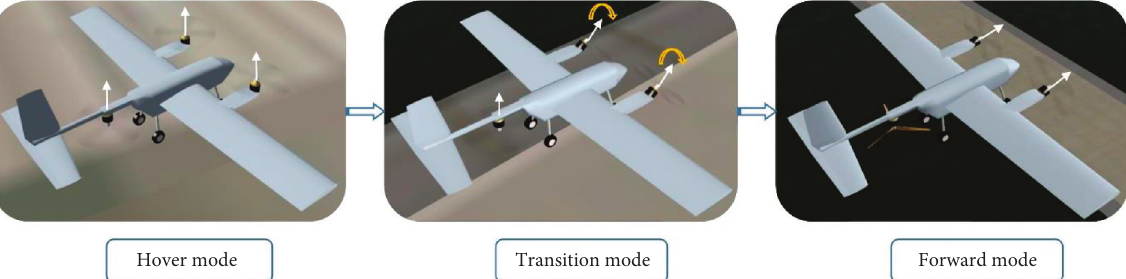
Figure 13: Mode transition in HIL simulation.